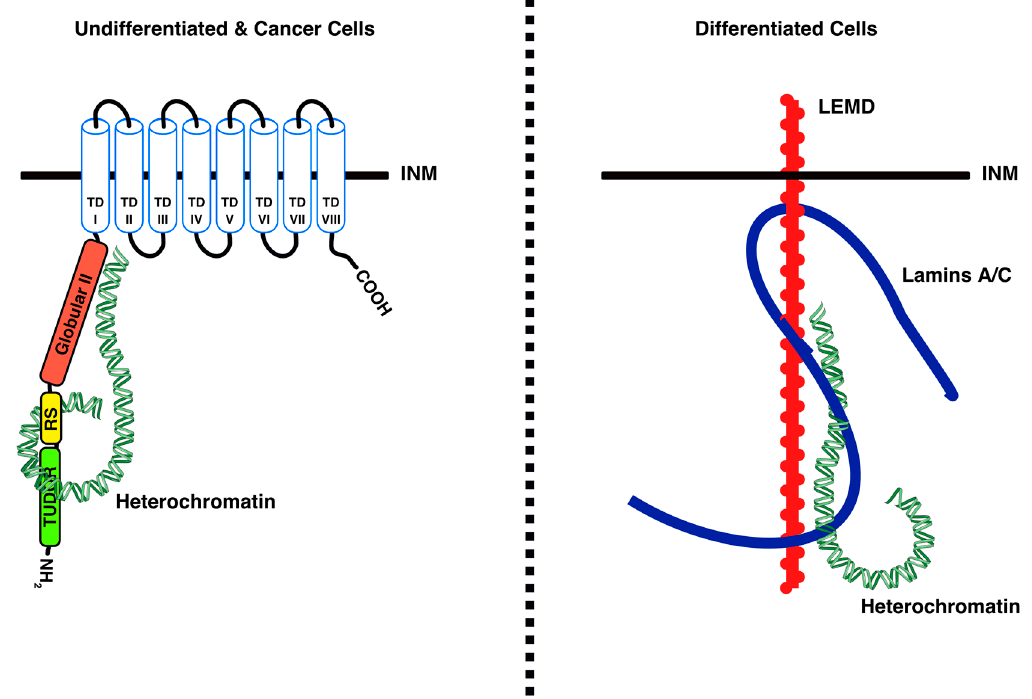
Figure 2. Schematic illustration of heterochromatin tethering to the INM. LBR directly tethers heterochromatin in undifferentiated and cancer cells (left panel), while lamin A/C indirectly tethers heterochromatin in differentiated cells, probably through the LEMD ([LAP2/emerin/MAN1] domain-containing) proteins. From Solovei et al. [4] with permission from Elsevier.